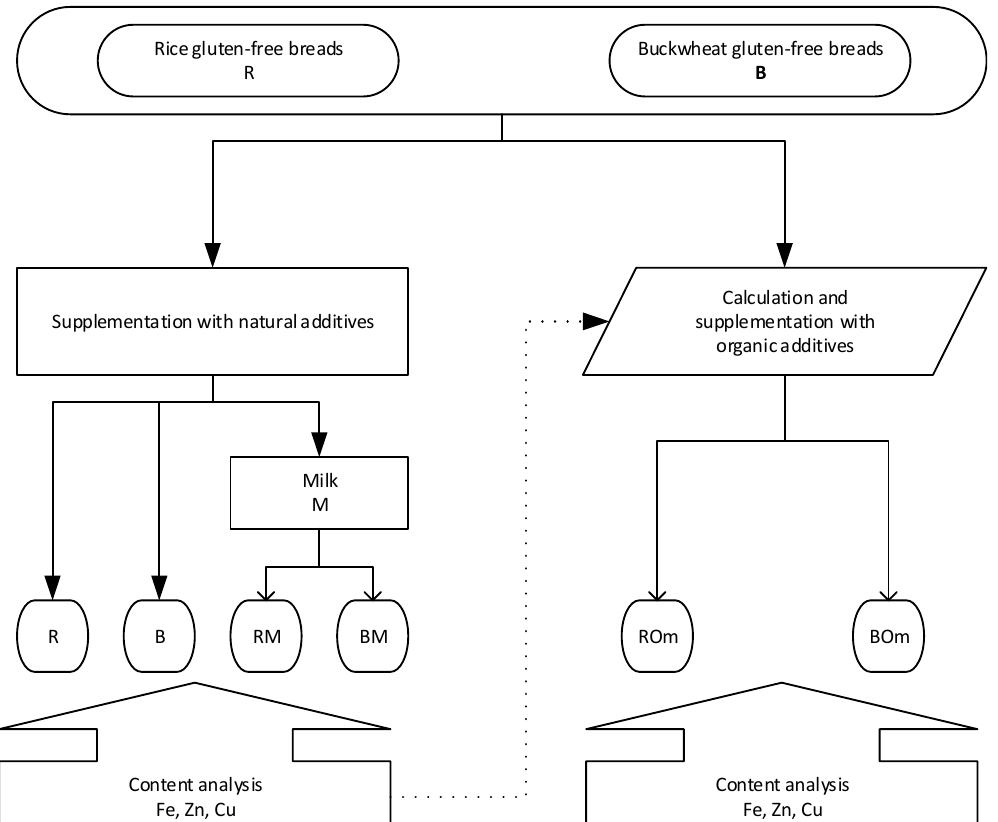
Figure 1. The stages of bread design. Breads: R—light, rice, B—dark, buckwheat, RM and BM—breads with milk and poppy seeds, ROm and BOm—breads with synthetic additives.